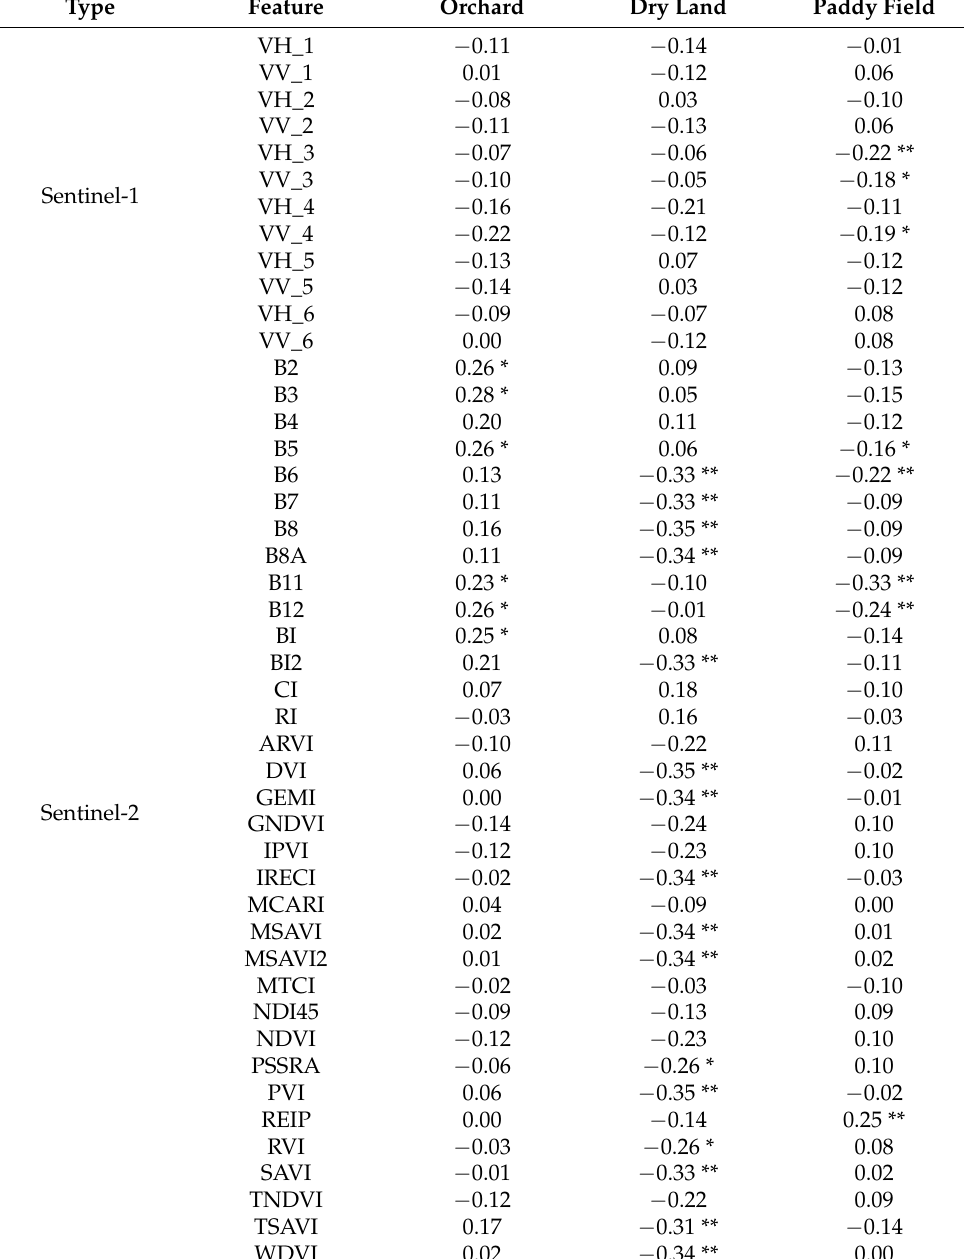
Table A5. The co-relationships between SOC (%) and environmental variables under orchard, dry land, and paddy